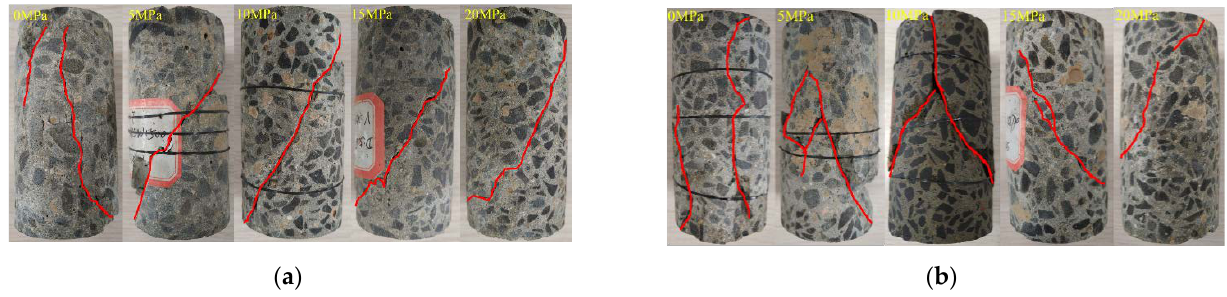
Figure 3. Failure modes of C60 and C70 high-strength concrete at different confining pressures. ( a ) C60 and ( b ) C70.